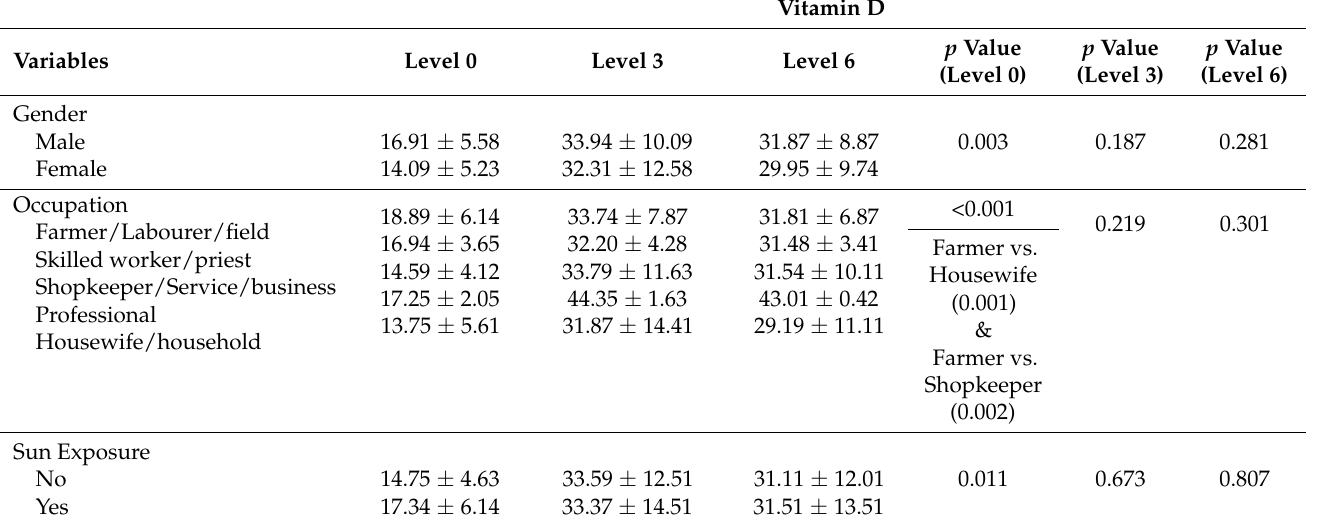
Table 3. Testing Vitamin D with Categorical